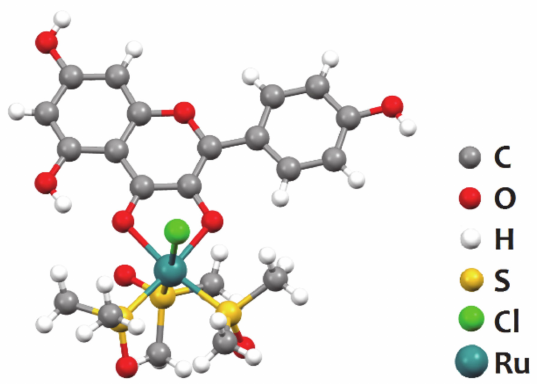
Figure 2. Structure of [Ru(DMSO) 3 (kaempferol)Cl], represented using the ball-and-stick style. Re- drawn from the atomic coordinates available at the CCDC (refcode XETLEK) using the software Mercury